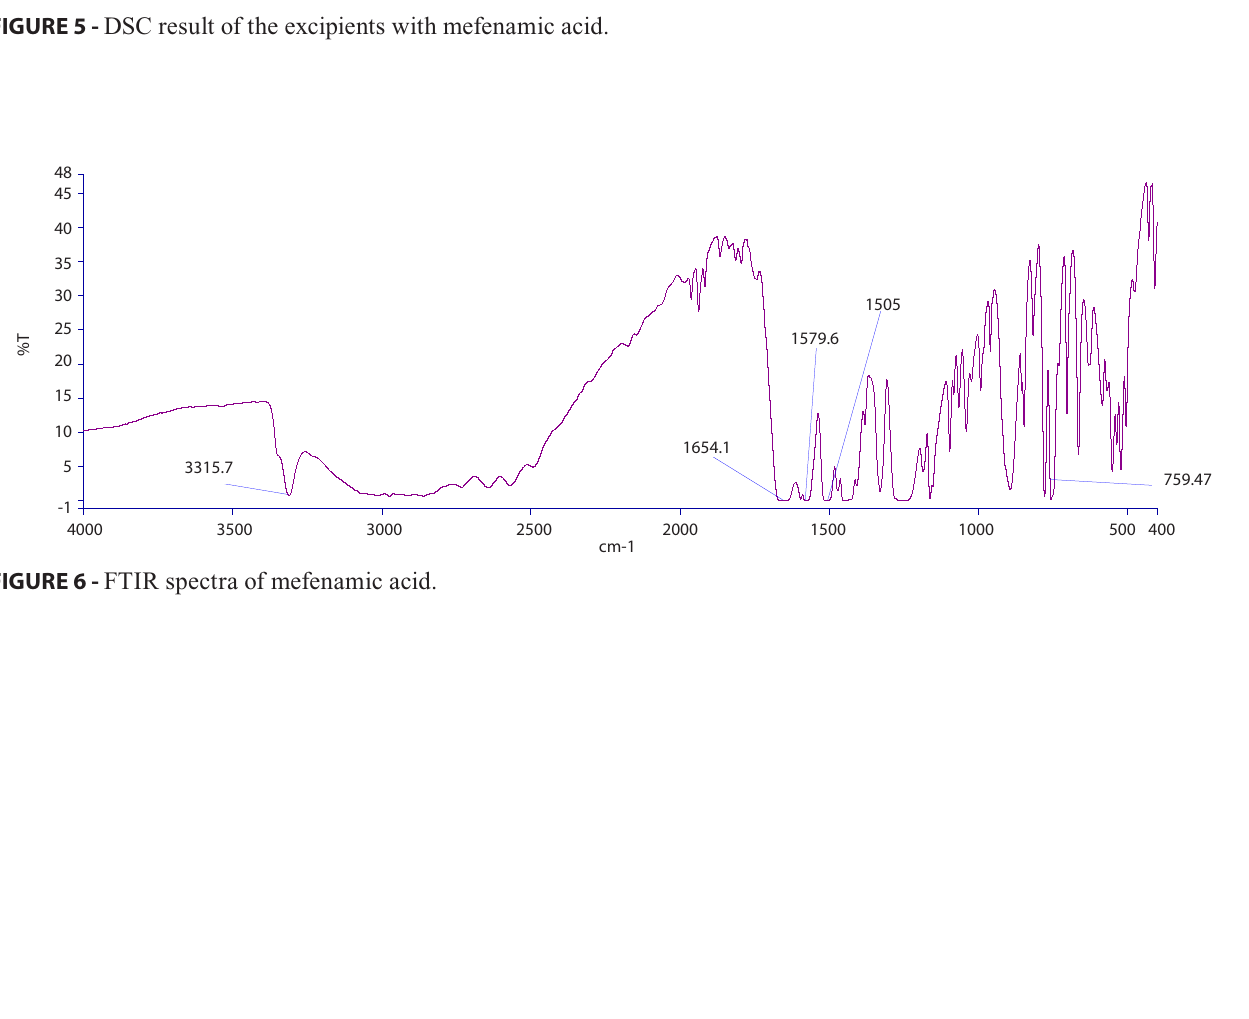
FIGURE 5 - DSC result of the excipients with mefenamic acid.